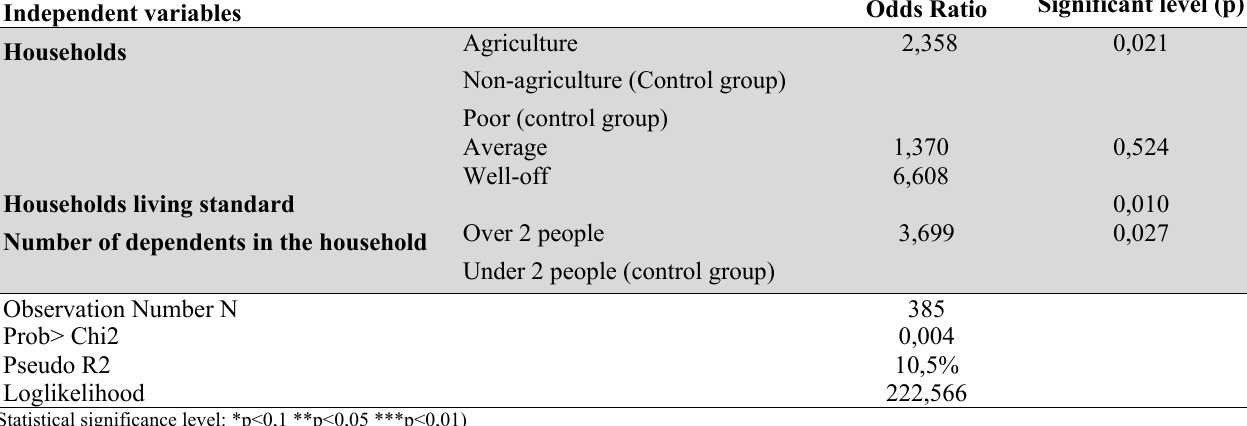
Results of estimating logistic models of household characteristics affecting household